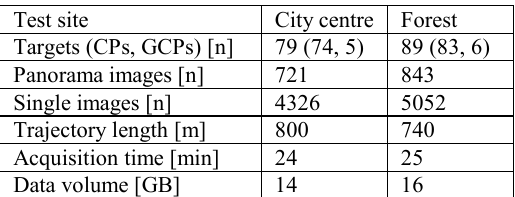
Table 2. Key figures relating to data acquisition for the performance